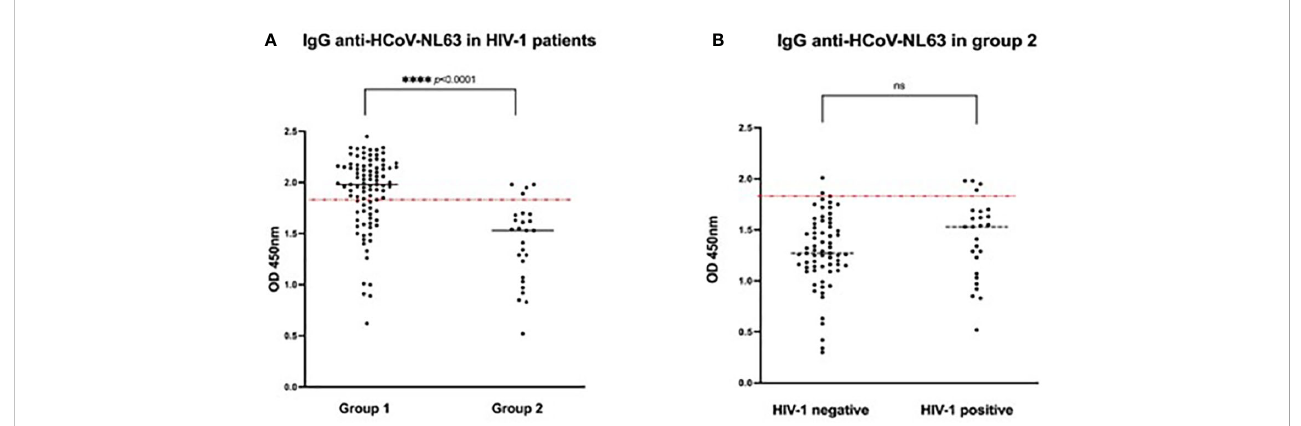
FIGURE 3 Seroprevalence of HCoV-NL63 in (A) HIV-1 positive patients (n=120) from both patient groups (group 1: asymptomatic with positive SARS-CoV-2 serology, n = 94; group 2 hospitalized COVID-19 patients, n=26) and (B) Group 2 patients (hospitalized COVID-19 patients, n=92) strati fi ed according to their HIV-1 status (HIV-1 negative, n=66, HIV-1 positive, n=26). Results are represented by the Optical Density units. The cut-off was determined by the mean OD + 25 of 12 pre-pandemic samples and is indicated by the dotted line (cut-off 1.85). (ns, non- signi fi cant; **** p < 0.0001). Signi fi cances are indicated by p -values which were considered signi fi cant if